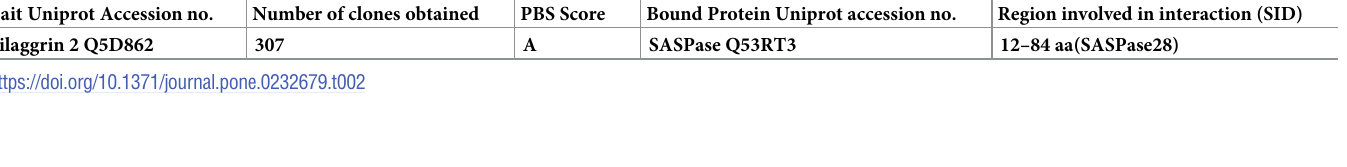
Table 2. Filaggrin 2 N-terminus (aa 2–213) interacts with the N-terminus of SASPase 28 protein. An Y2H analysis using filaggrin 2 N-terminus (aa 2–213) as bait was used to screen more than 68 million clones in the random primed human reconstructed skin library. 307 out of a total of 325 positive interactions represented sequences from SASPase (Q53RT3) with a PBS score class A and a SID domain between amino acids 12 and 84 in the N terminal domain of SASPase 28. Bait Uniprot Accession